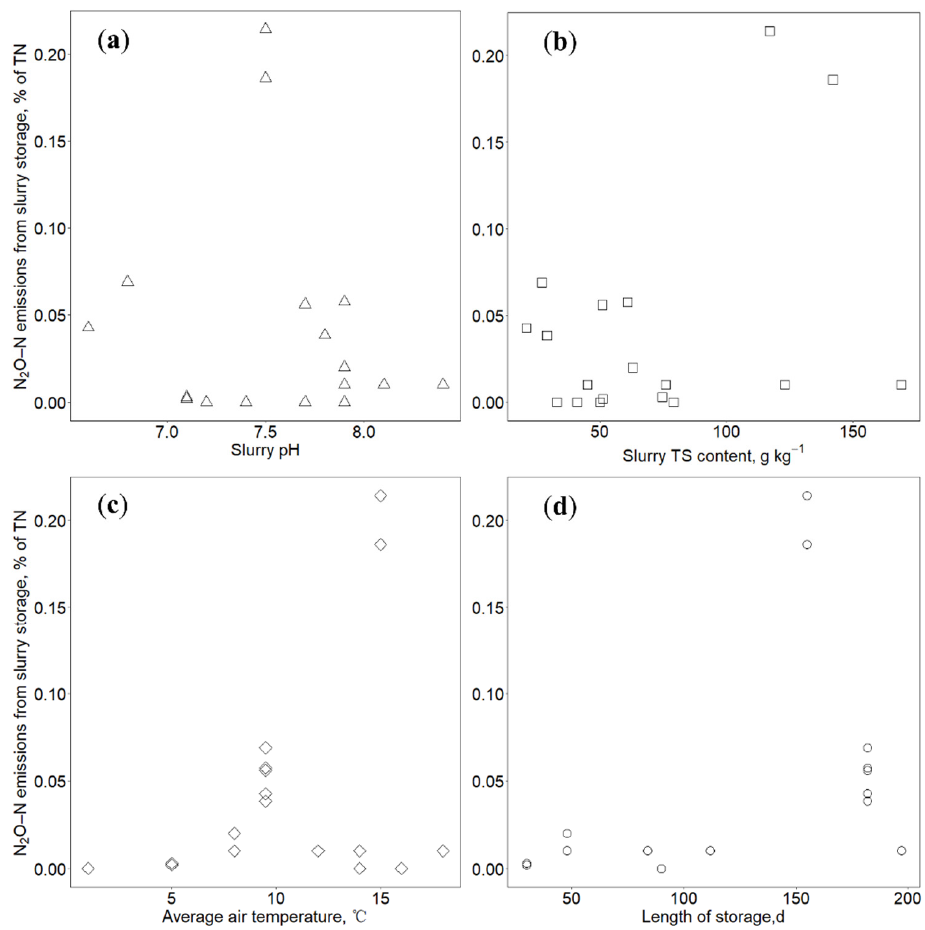
Figure 2. Relationships between N 2 O–N emissions from slurry storage with ( a ) slurry pH (in triangle), ( b ) total solids (TS) content (in square), ( c ) air temperature (in diamond) and ( d ) length of storage (in circle).